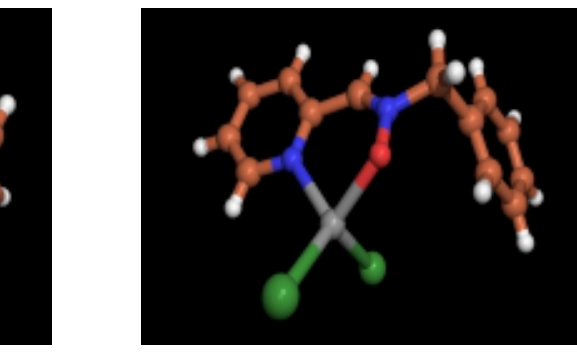
Figure 1. X-ray structure of nitrone 2 Figure 2. X-ray structure of complex